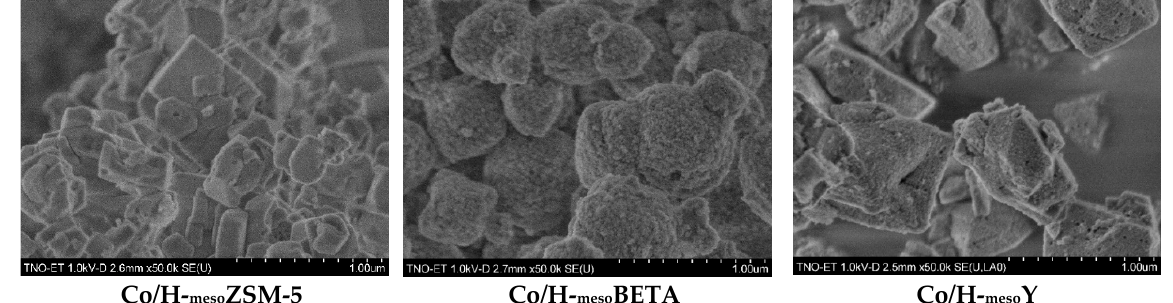
Figure 3. SEM images of the bif. catalysts.